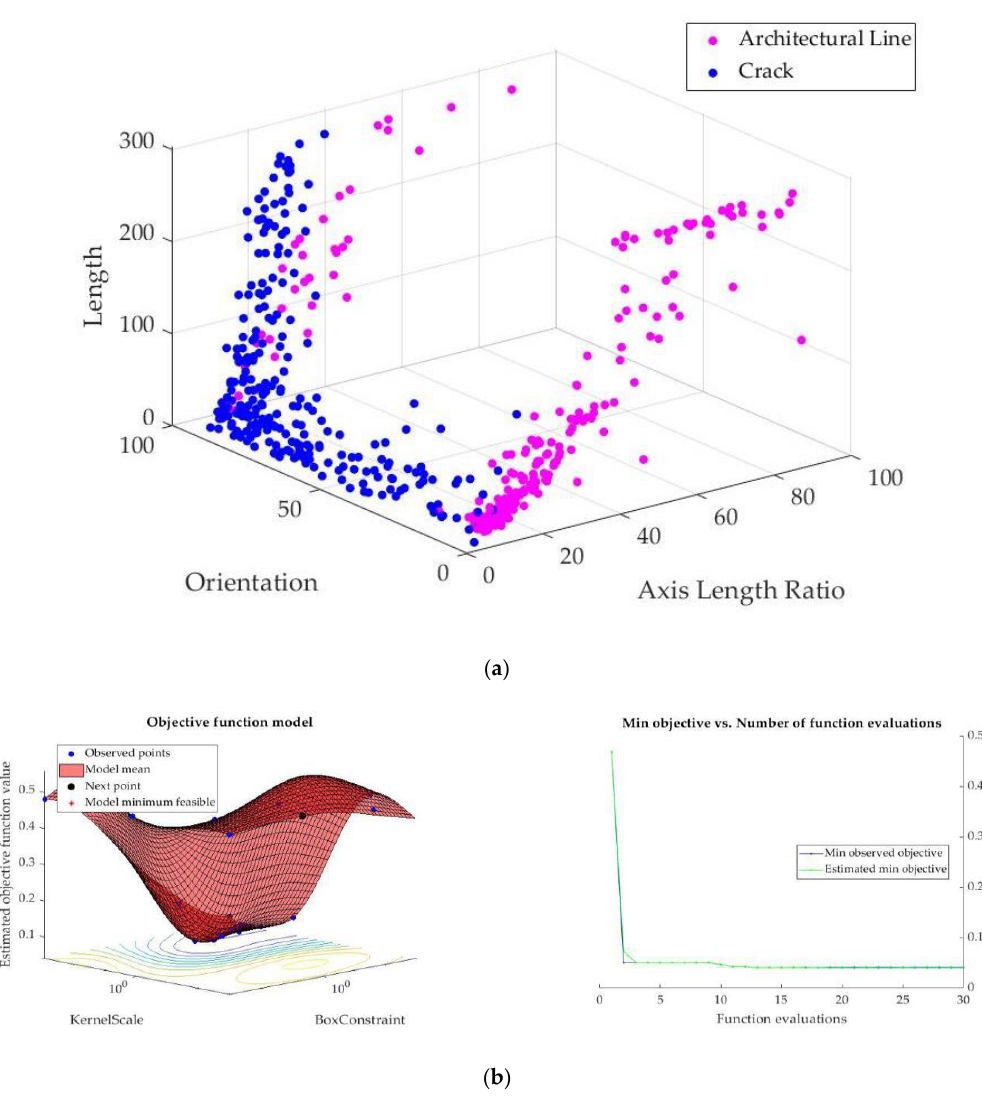
Figure 10. Support vector machine (SVM)-based Classifier. ( a ) Three-dimensional (3D) feature space and ( b ) classification performance.